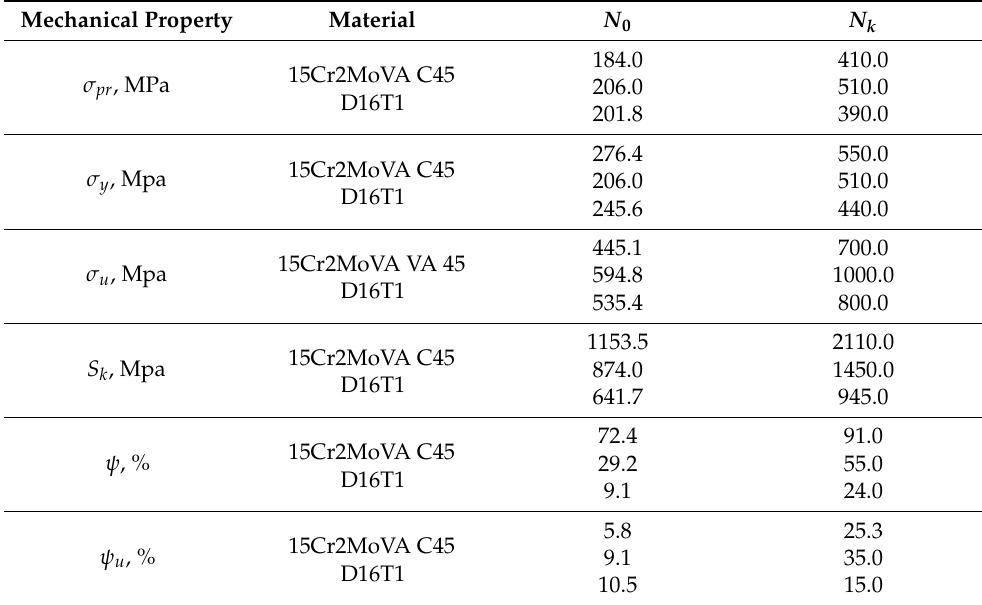
Table 4. Sensitivity thresholds for mechanical